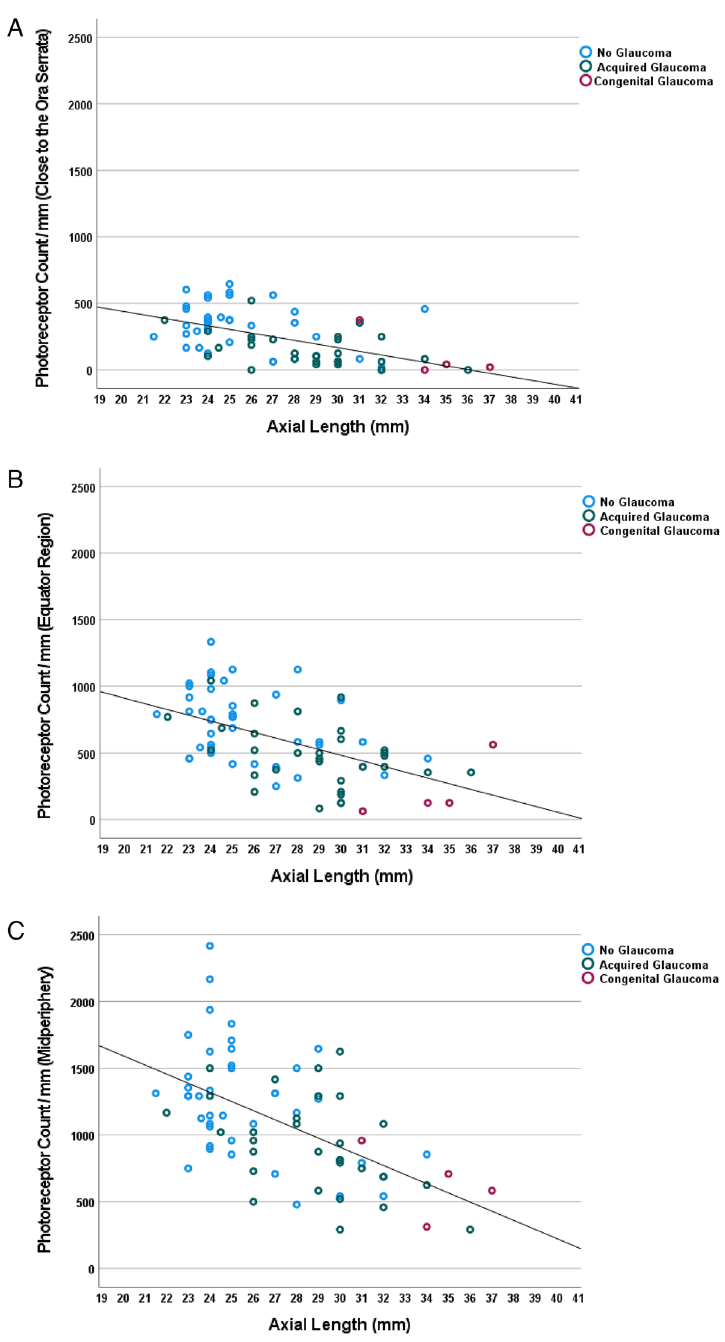
Figure 3. Scattergram showing the distribution of the retinal photoreceptor cell count / mm in relationship to axial length, as measured close to the ora serrata ( a ), at the equator ( b ) and in the fundus midperiphery (midpoint between equator and posterior pole) ( c ). ( a ) Equation of the regression line: Photoreceptor Count/mm = − 28.8 × Axial Length (mm) + 1033. ( b )Euation of the regression line: Photoreceptor Count/ mm = − 44.5 × Axial Length (mm) + 1819. ( c ) Equation of the regression line: Photoreceptor Count/ mm = − 69.8 × Axial Length (mm) +